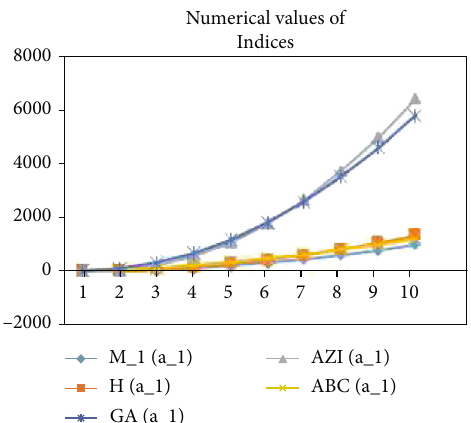
Figure 5: Comparison of indices for HDN4 ð 4 Þ .